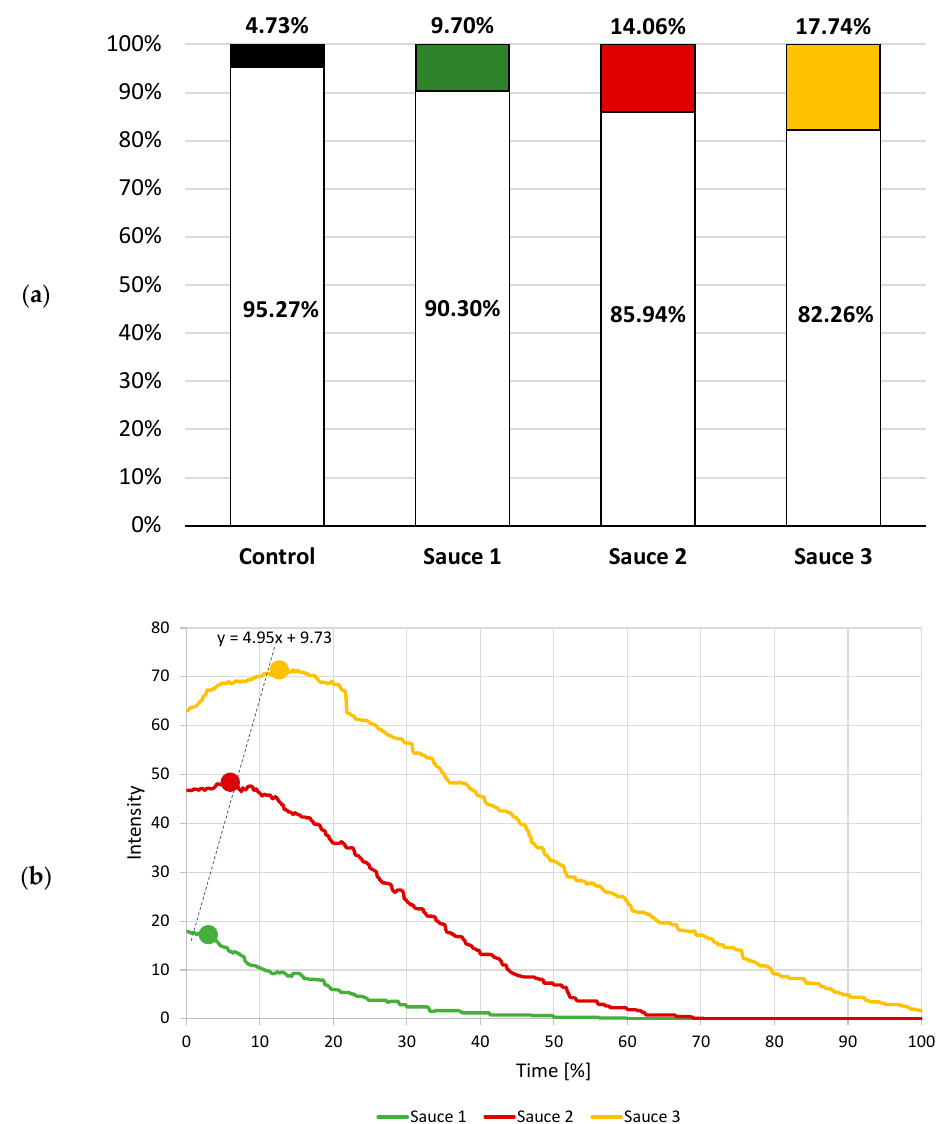
Figure 4. ( a ) Relative contribution of emotions observed during mastication and ( b ) time-intensity average curves after mastication of grilled meat with three different sauces. (cid:3) Neutral emotion; (cid:3) “Control” non-neutral emotion; (cid:3) “Sauce 1” non-neutral emotion; (cid:3) “Sauce 2” non-neutral emotion; (cid:3) “Sauce 3” non-neutral emotion. Legend: Control—no sauce; Sauce 1—Tabasco Brand Green Jalapeño Sauce; Sauce 2—Tabasco Brand Original Red Sauce; Sauce 3—Tabasco Brand Habanero Pepper Sauce.